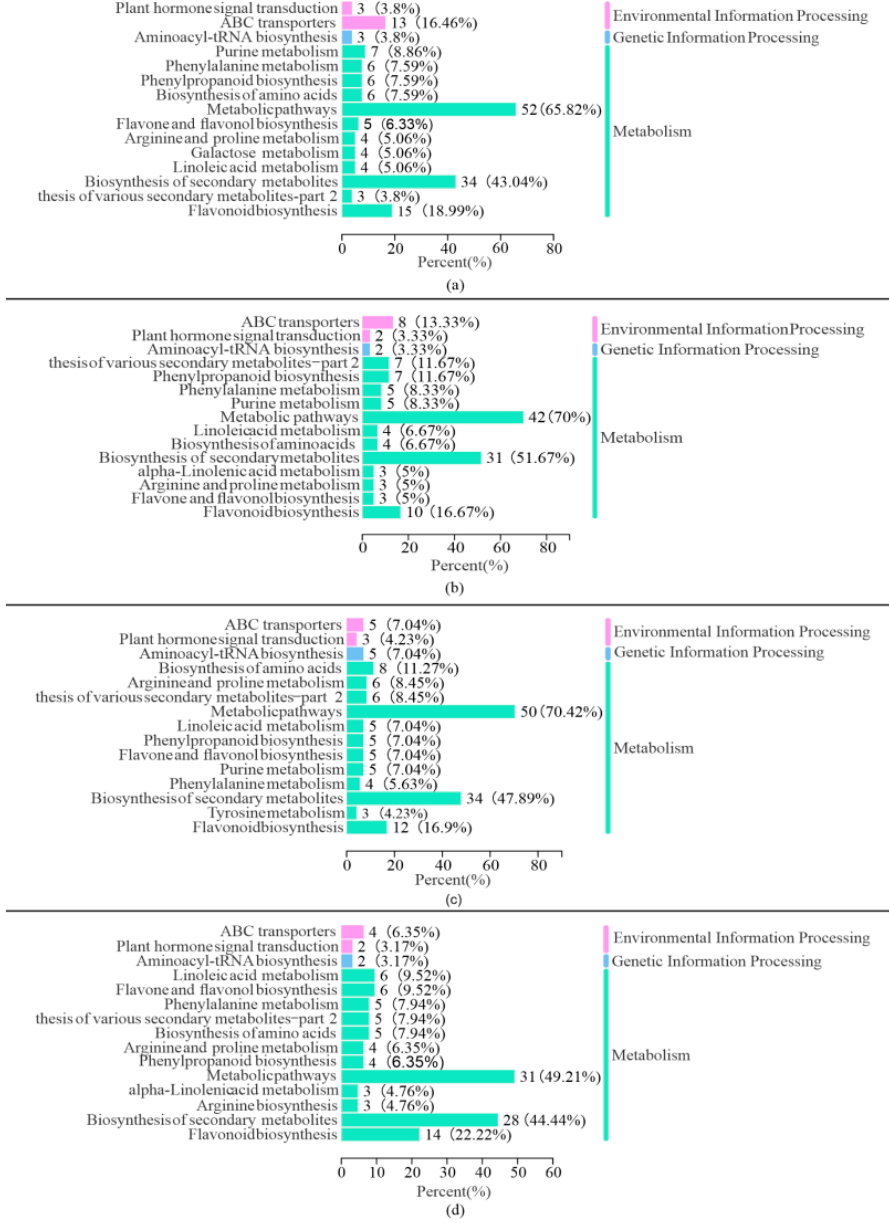
Figure 3. Bar plot of the top 15 clustered KEGG pathways of the DAMs. ( a ) Comparison group of 0 h vs. FS 2 h. ( b ) Comparison group of 0 h vs. FS 8 h. ( c ) Comparison group of FS 2 h vs. LCC 2 h. ( d ) Comparison group of FS 8 h vs. LCC at 8 h. The horizontal coordinate is the percentage of DAMs annotated to the pathway, and the vertical coordinate is the pathway name. Different colors represent different biological processes.